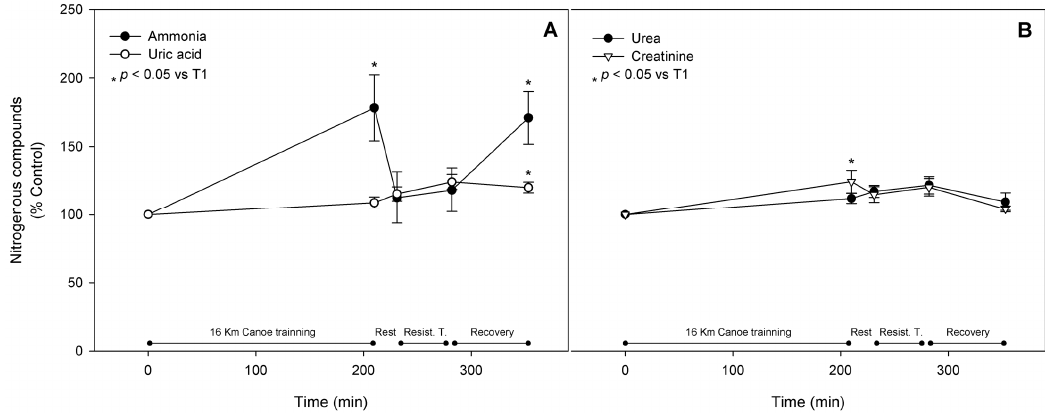
creatinine fluctuations are presented in ( Panel B ). Nitrogenous compounds were evaluated as reported in materials and methods and are shown as mean ± standard error of percentage values against control. * Indicates statistical difference against control values ( p <